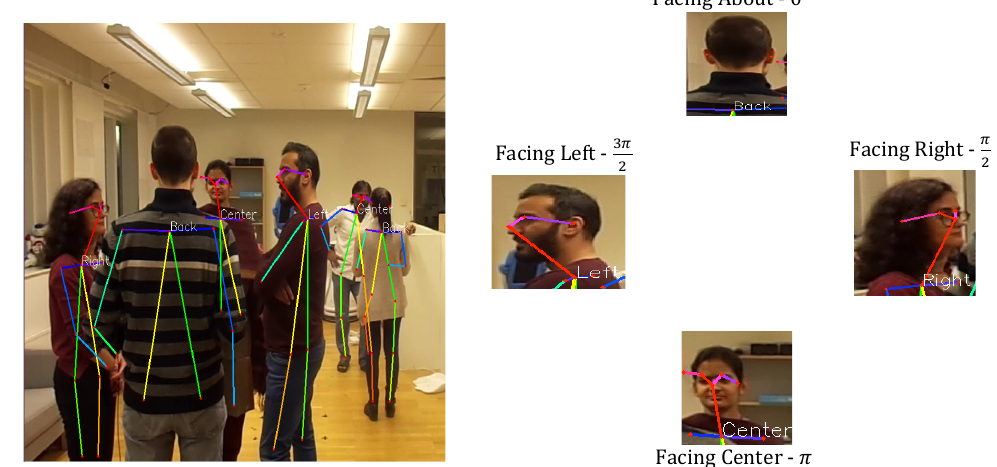
Figure 5. V6KP estimates the head orientation of people in the scene. The left part presents one image of two groups interacting in the scene. One group comprises four members and the second group comprises two members. The right part presents four images of the individual people being detected and their head orientation is calculated for the first group. The cropped images of their head and their facing direction along with orientation are presented in the right